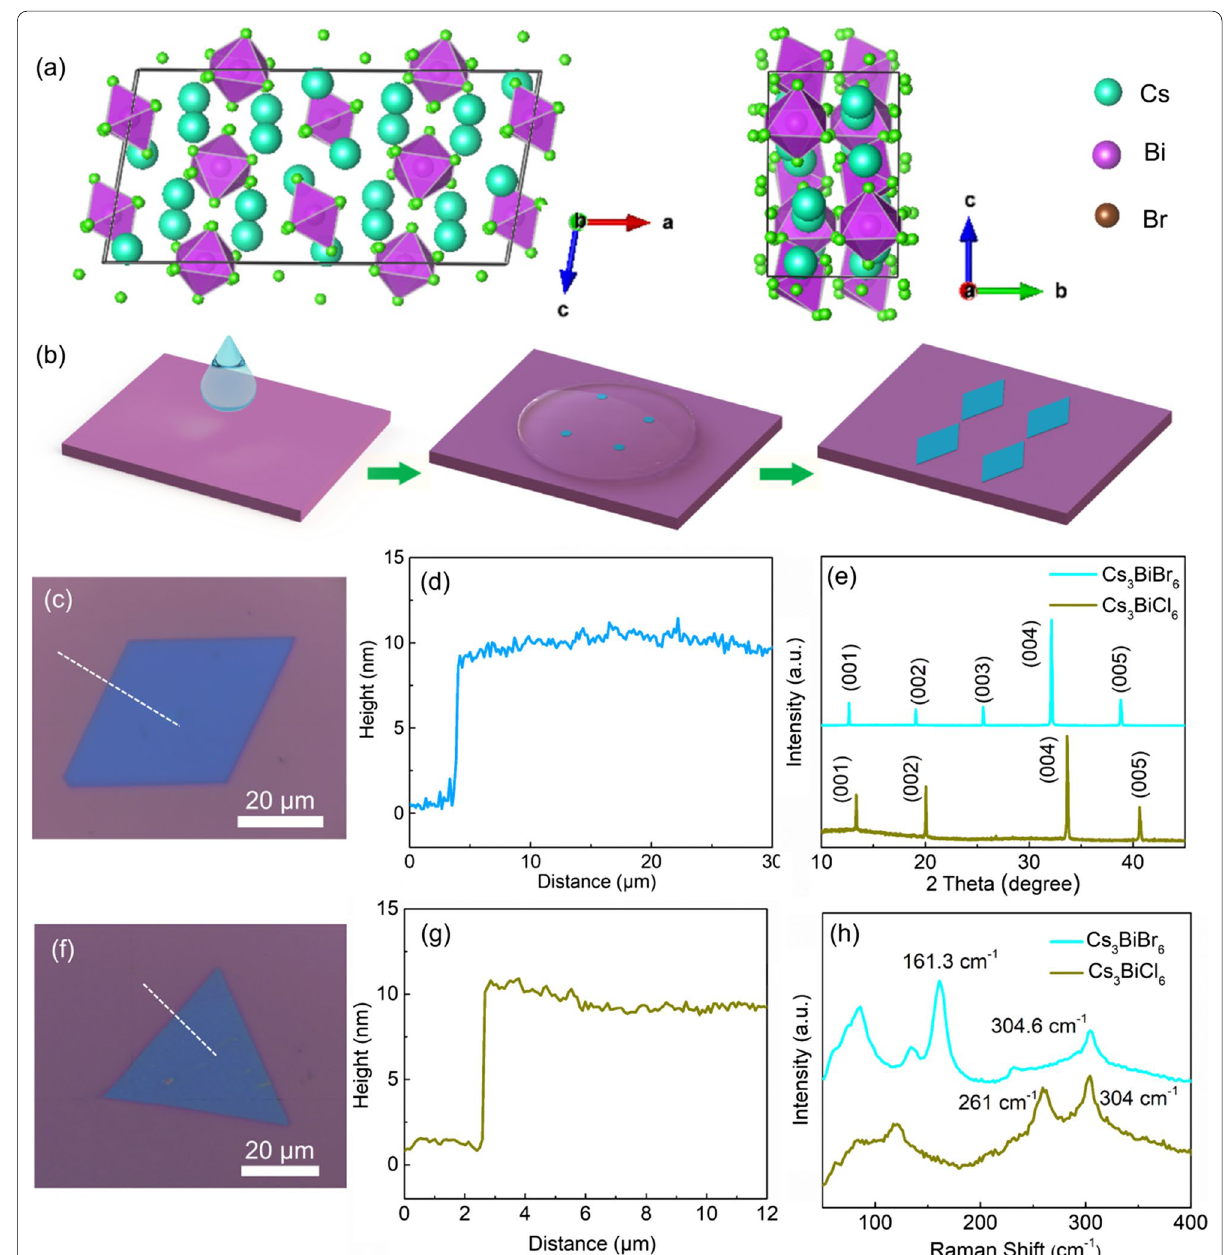
Fig. 1 a Schematic diagram of the Cs 3 BiBr 6 zero-dimensional structure: top view (left) and side view (right). b Schematic procedure of Cs 3 BiBr 6 film growth. c Optical microscope image of the obtained Cs 3 BiBr 6 films. d Height profile obtained from the AFM profile image of the Cs 3 BiBr 6 film in ( c ). e XRD patterns of the Cs 3 BiBr 6 and Cs 3 BiCl 6 films. f Optical microscope image of the obtained Cs 3 BiCl 6 films. g Height profile obtained from the AFM profile image of the